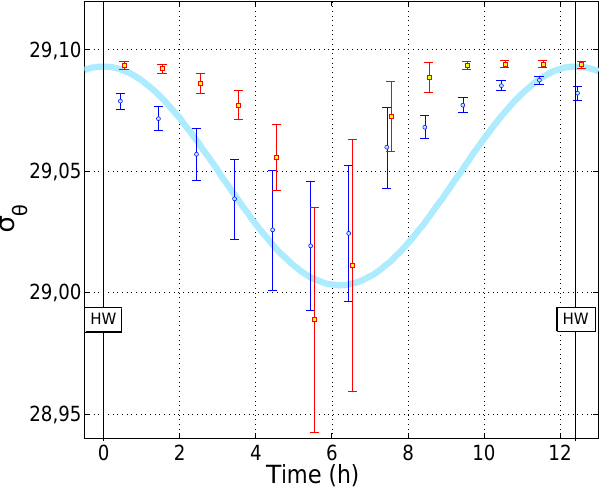
Figure 2. Time series of potential temperature, salinity, and σθ col- lected at CSN, CSS, and ESP sills (see legend). The strong fluctu- ations correspond to periods of spring tide and are greater in CSS than in CSN, being the smallest in ESP. A noteworthy fact is the similitude of CSN and ESP temperature (CSS is clearly cooler) and of CSN and CSS salinity (ESP is clearly fresher).